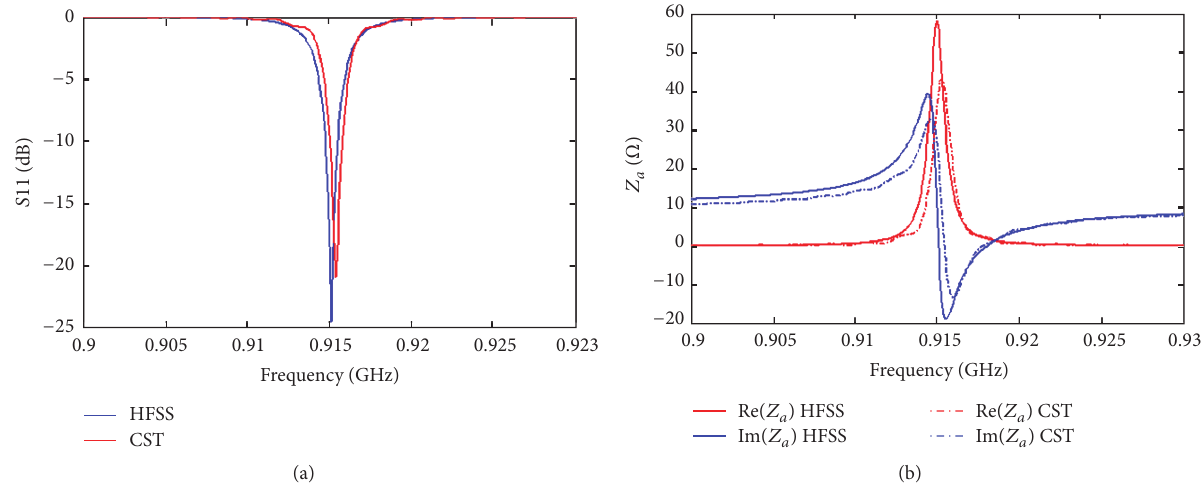
Figure 29: Circuit parameters of the 3D spherical antenna (Table 11): (a) return loss 𝑆11 , (b) input impedance 𝑍 𝑎 .